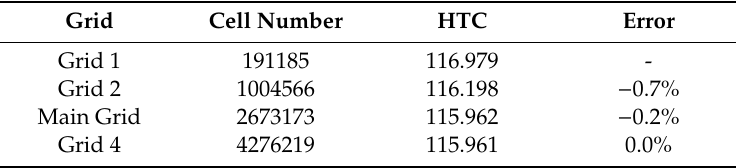
Figure 4. Channel gridding. Table 6. Cell number studied in mesh independent